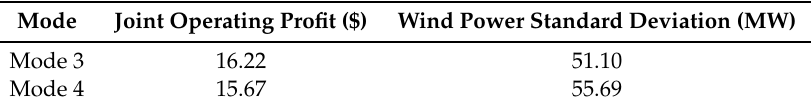
Table 3. Comparison of optimization effects in two